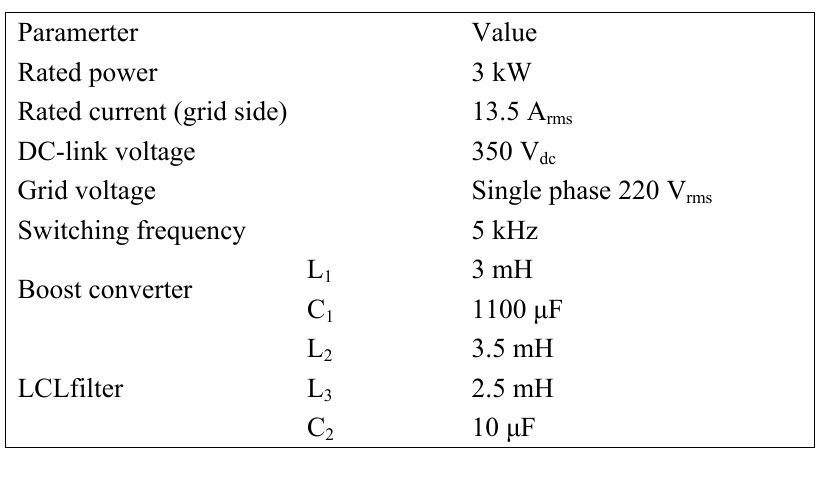
Figure 12. Experimental